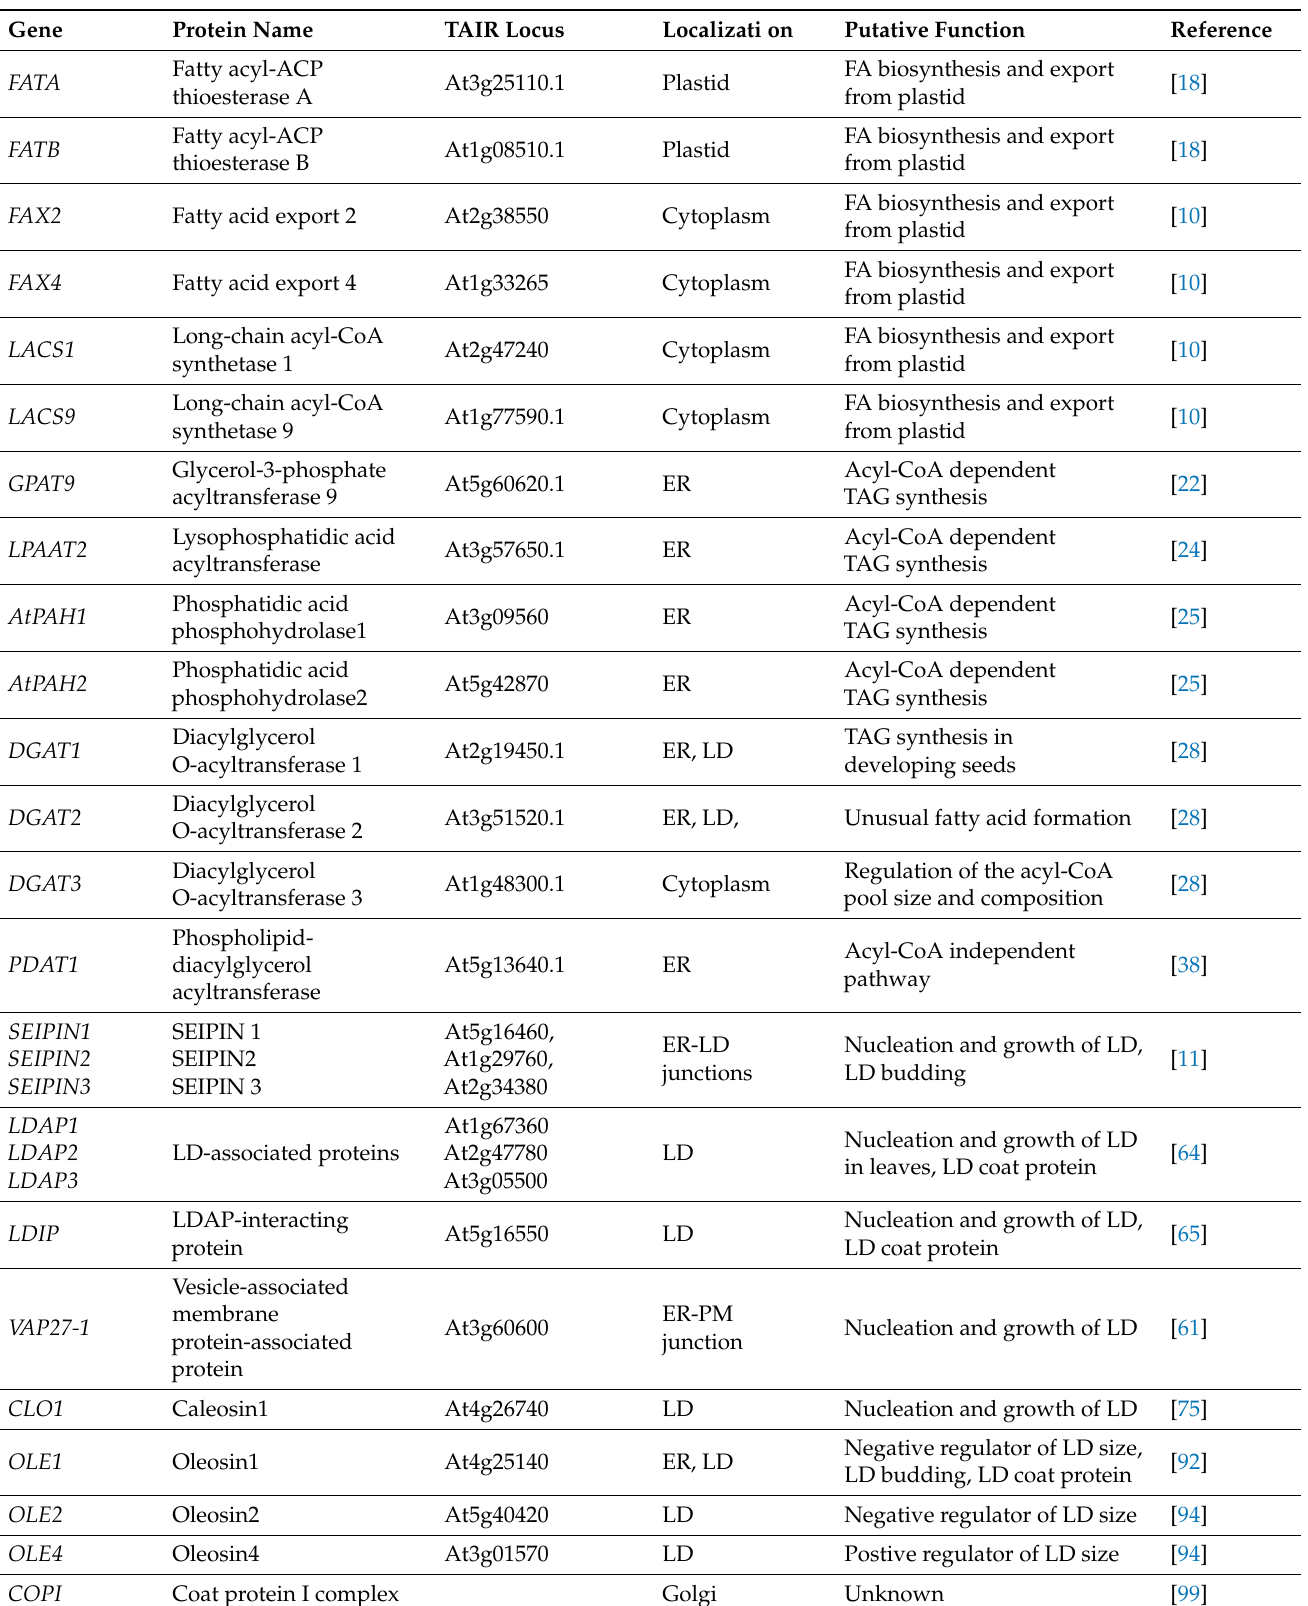
Table 1. Identified genes and proteins involved in LD biogenesis in Arabidopsis thaliana